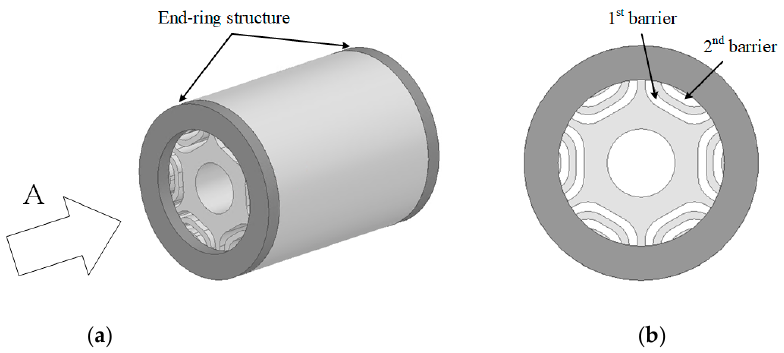
Table 4. Permanent magnet data.